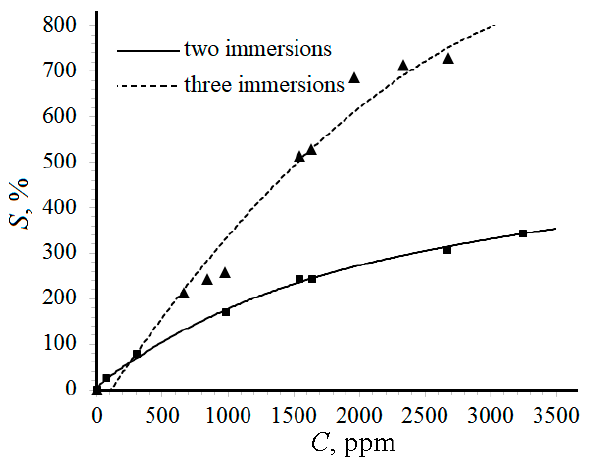
Figure 6. Concentration dependence of gas sensitivity for the ZnO/ZnO–Cu samples ( T = 300 ° С ).